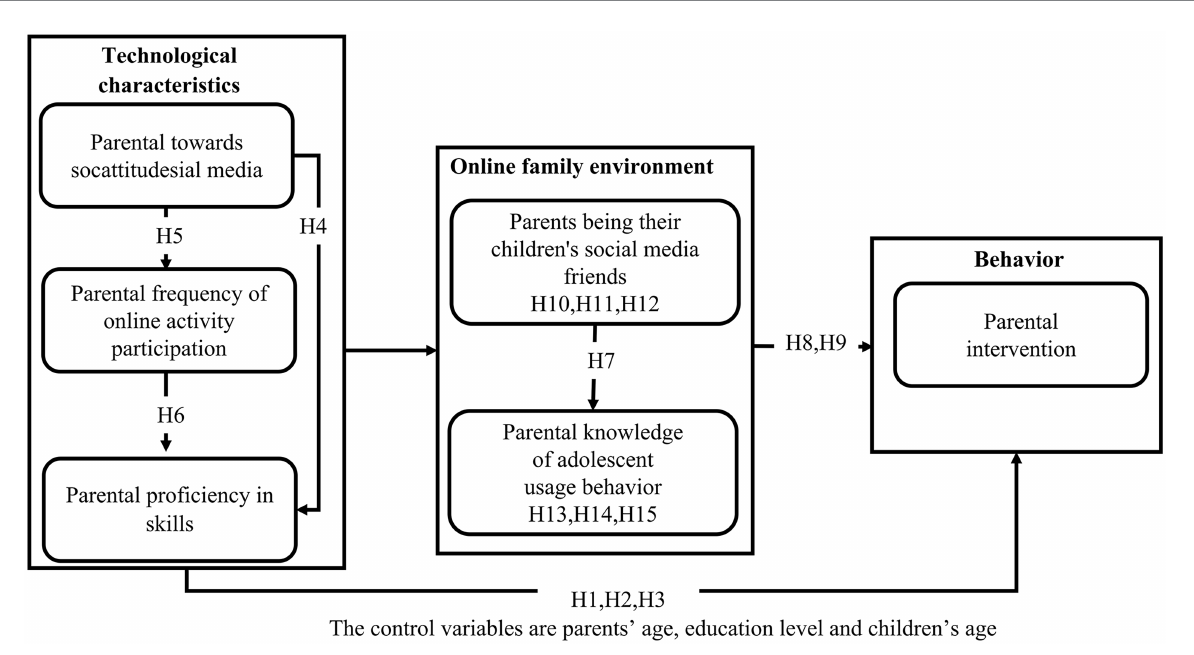
FIGURE 1 Predictive model of parental intervention